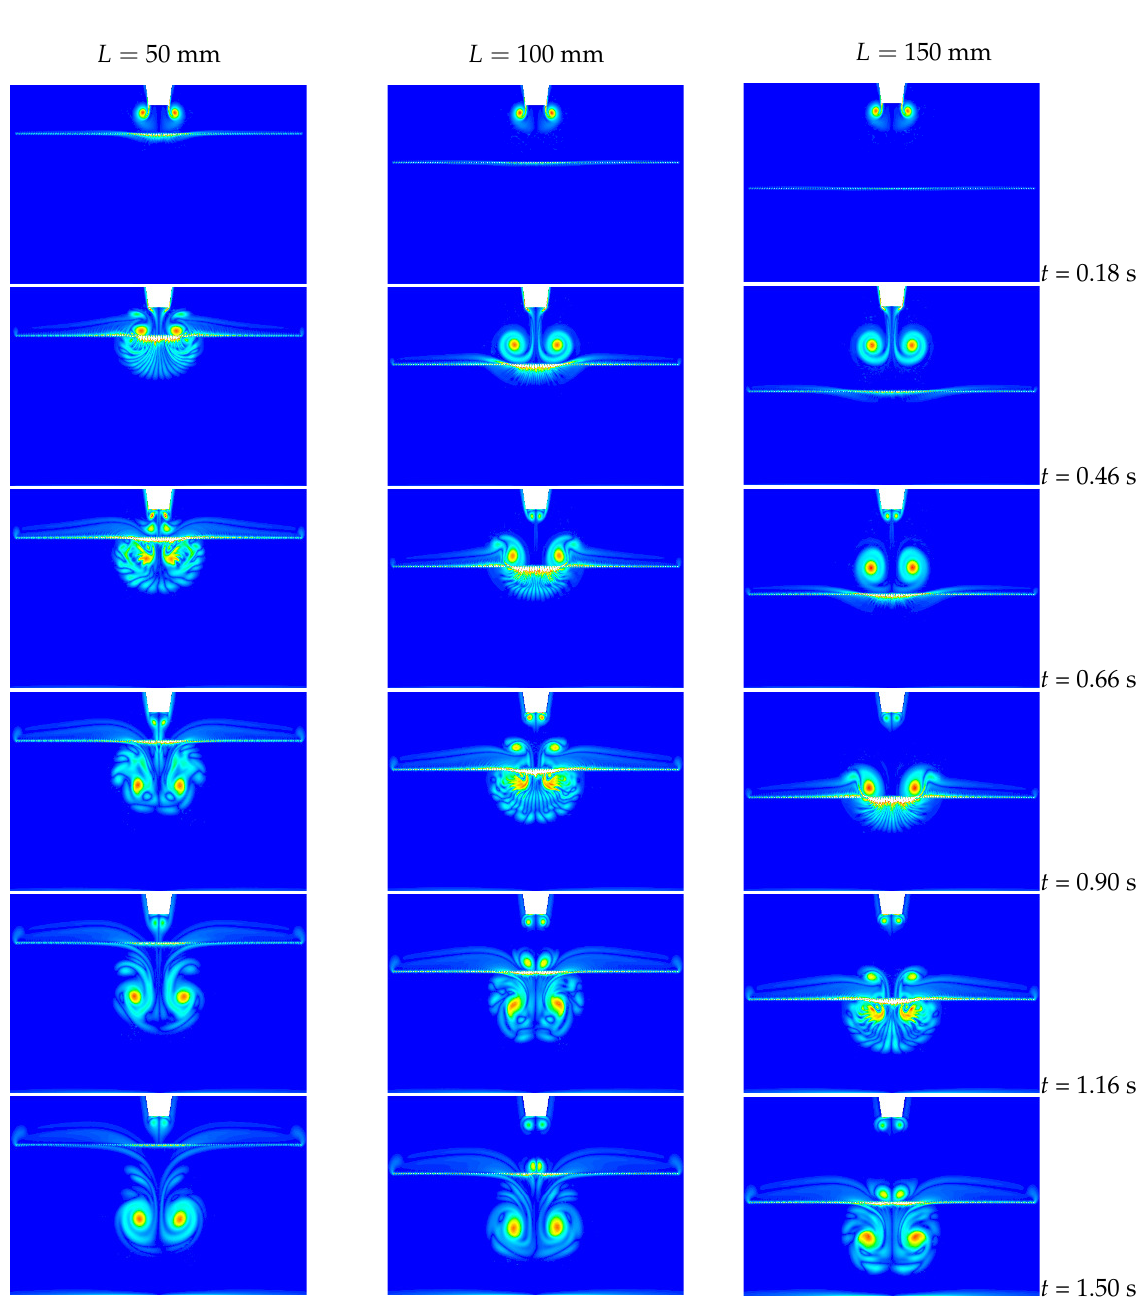
Figure 18. Vortex ring formation and interaction vs. distance variation.